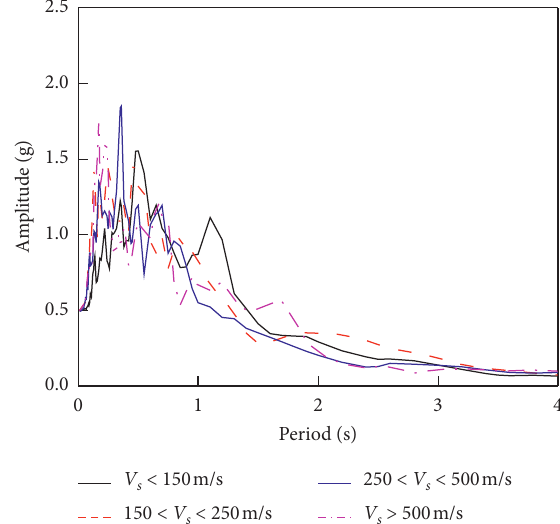
Figure 13: Scaled acceleration spectra for the selected ground motions in different soil